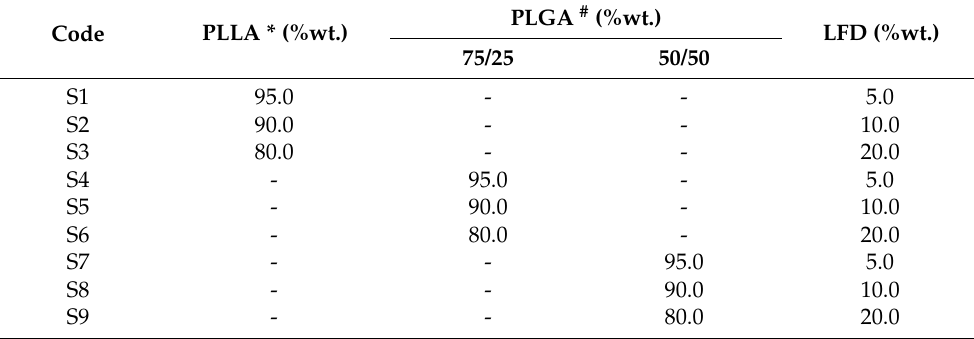
Table 1. LDF-loaded thin-film patches prepared via spin-coating